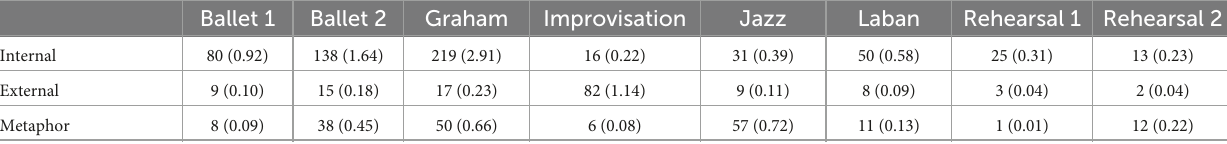
TABLE 4 Absolute numbers (TPM between brackets) focus of attention comments per